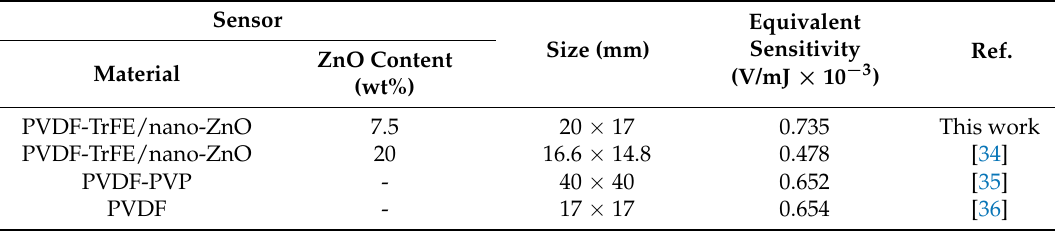
Table 1. Summary of PVDF-based sensors equivalent sensitivity in our study and reported